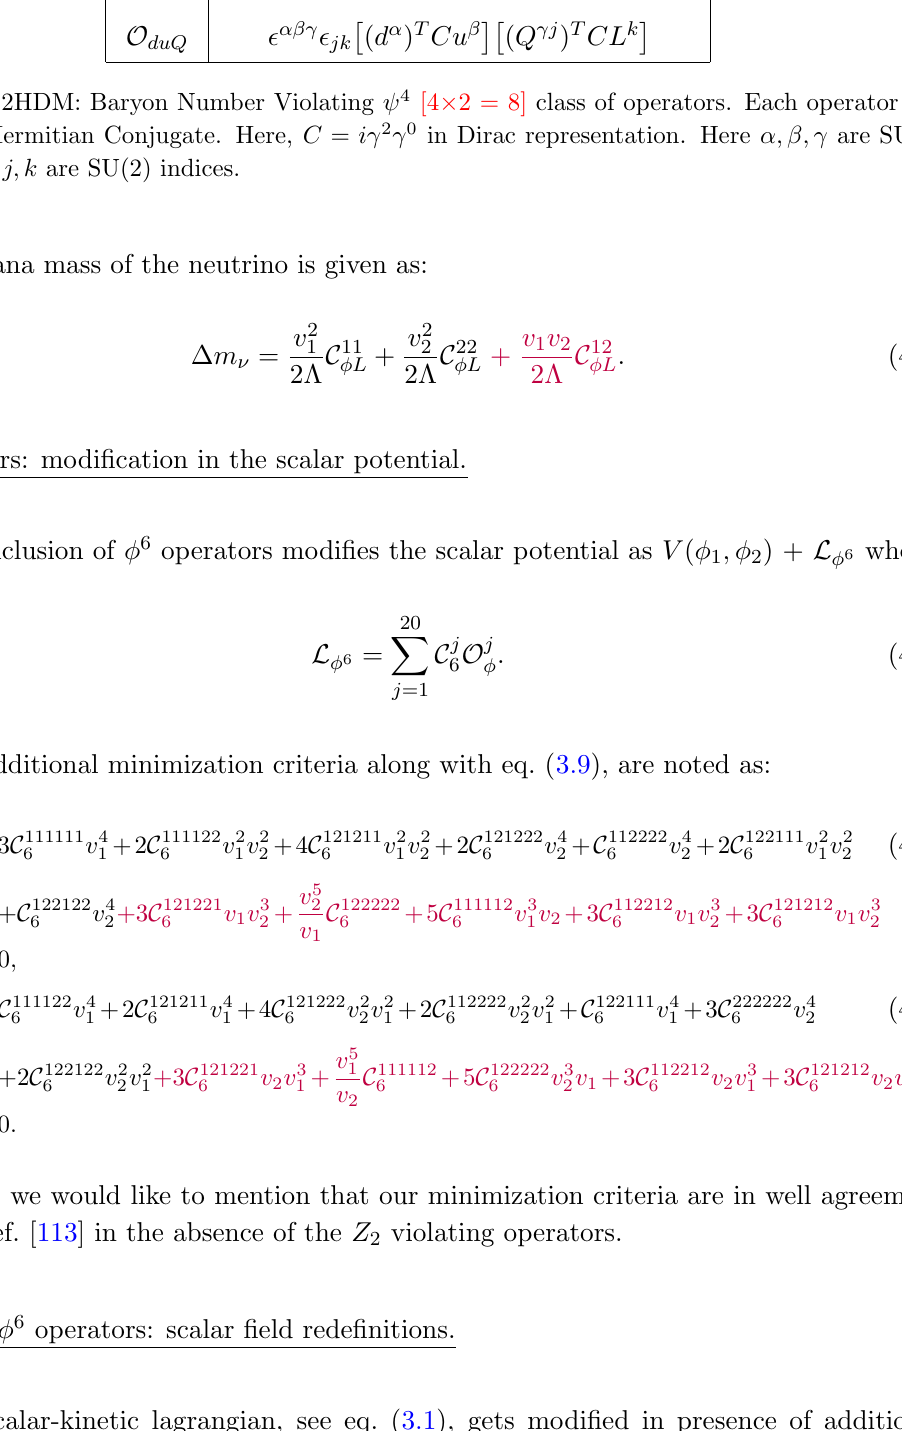
2 = 8] class of operators. Each operator has (cid:2)